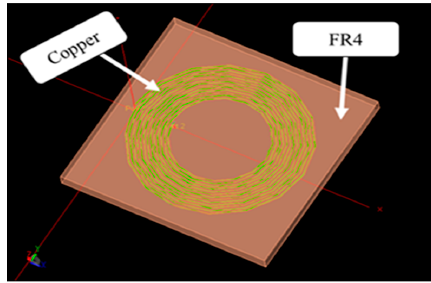
Figure 8. 3 Visualization of T X in ADS momentum.